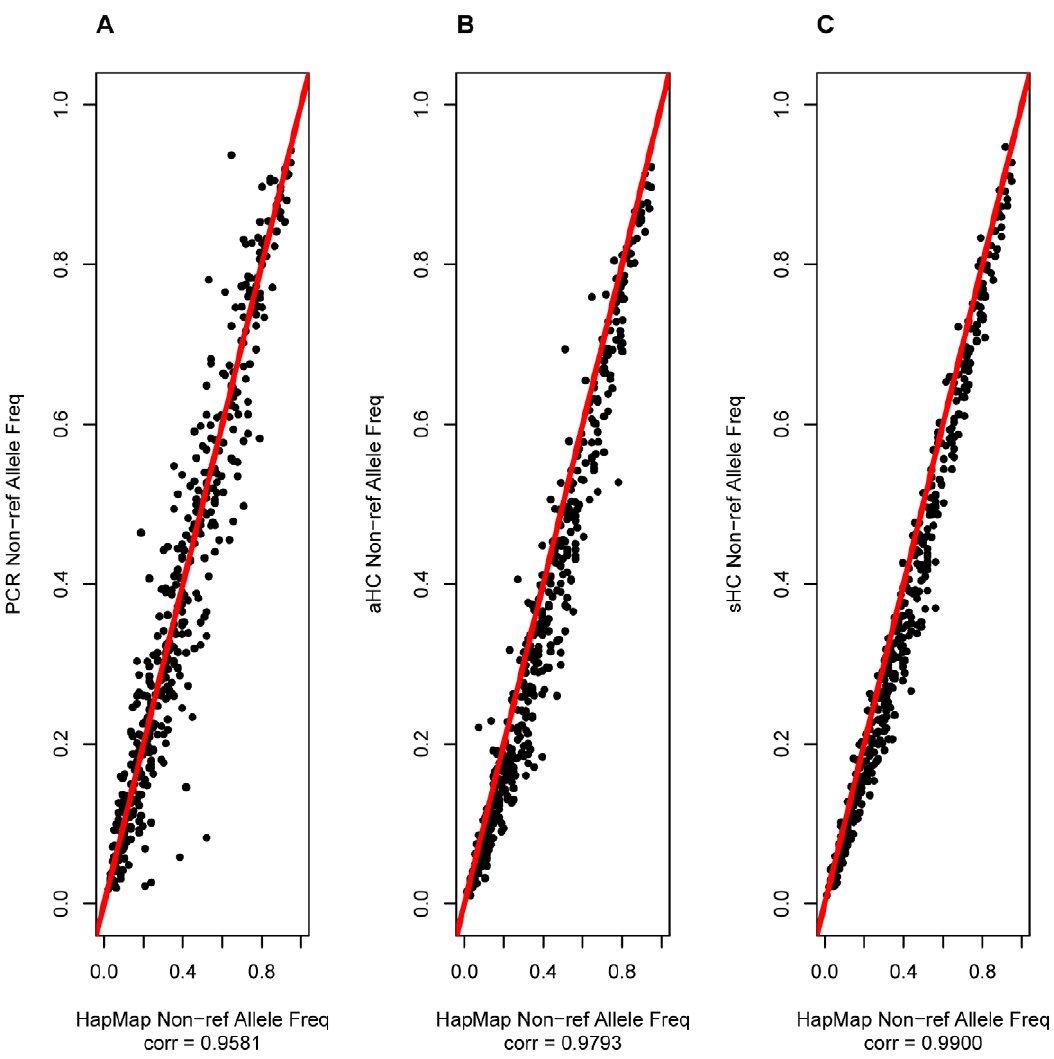
Figure 2. Accuracy of non-reference allele frequency estimation at HapMap/58C intersection variants for the Pool of 50 after duplicate removal. An analysis of the correlation between the non-reference allele frequency estimates from the sequencing based variant caller and the allele frequency calculated from the reference genotypes. The analysis includes the true positive variants called by the sequencing based variant caller for which there were ƒ 2 missing genotypes in the reference genotypes. The correlation coefficient is the Pearson’s correlation coefficient. The figure shows the analysis for: (A) PCR enrichment, (B) aHC enrichment and (C) sHC enrichment.